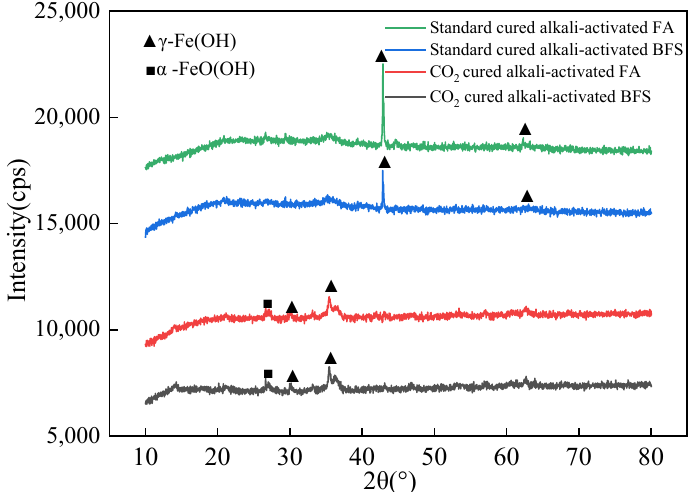
Figure 12. The X-ray diffraction (XRD) diagrams of the rust on the surface of steel bars.